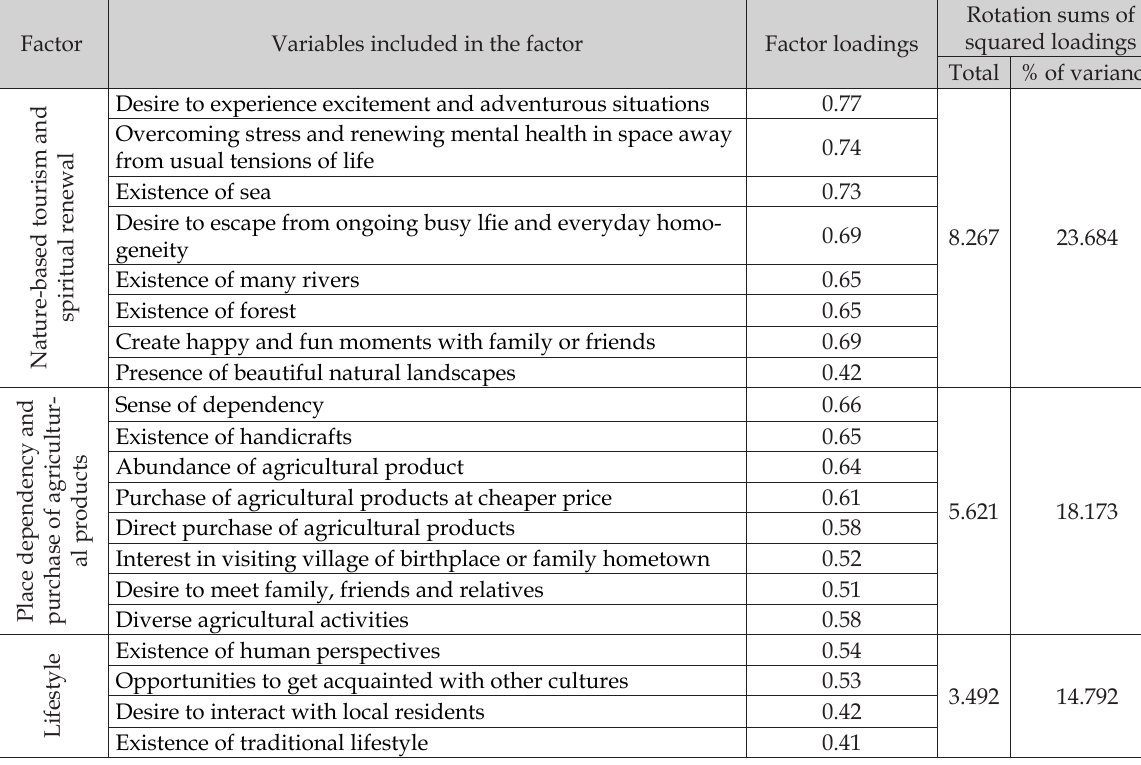
Table 6. Results of factor